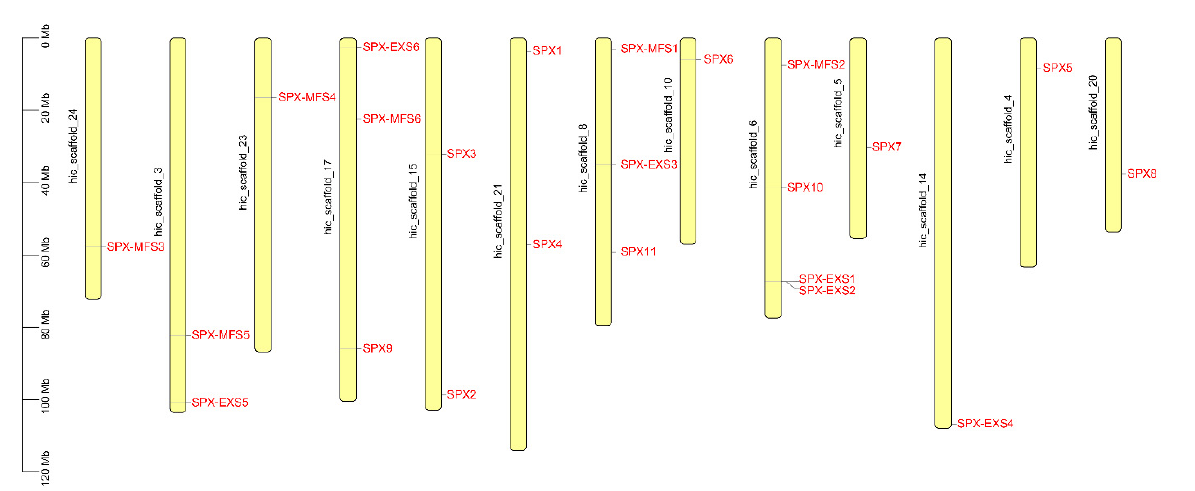
Figure 1. Chromosomal locations of the SPX-domain-containing proteins family genes in Phyllostachys edulis .